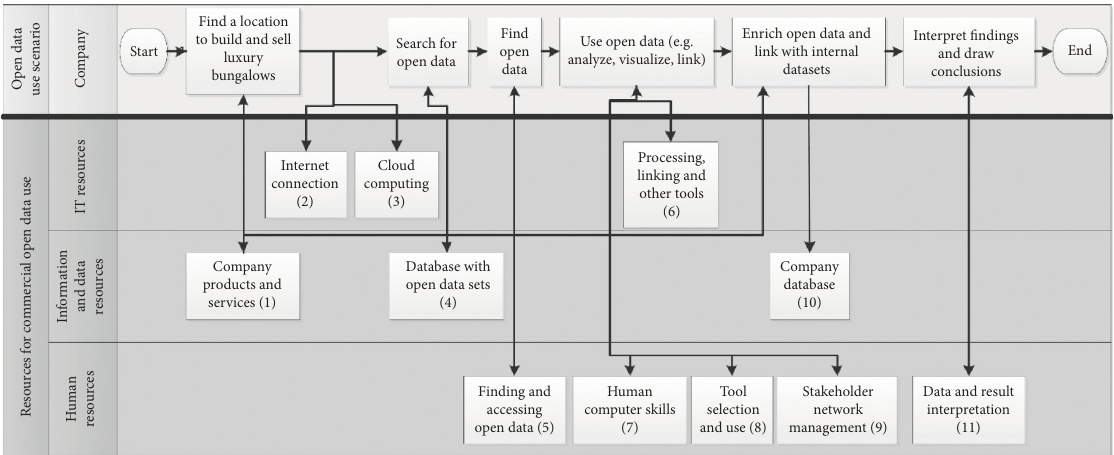
Figure 2: Open data resources model